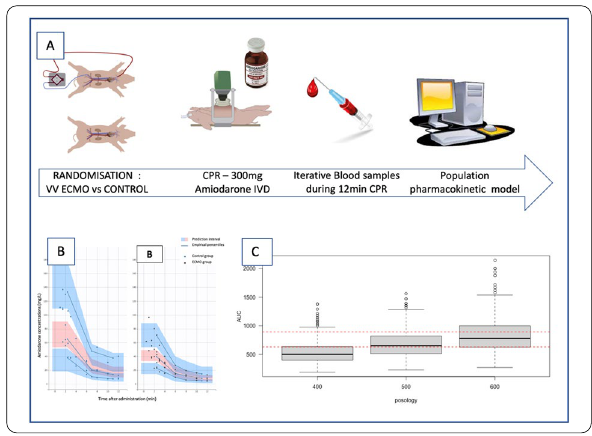
Panel A: experimental protocol. Panel B: Visual Predictive Check for ami- odarone model. Left panel: control group. right panel: ECMO group.